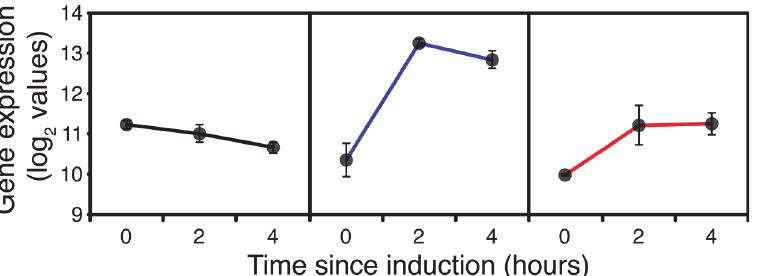
Fig 5. Expression of HAC1 during fed-batch culture, 0 (before), 2 and 4 hours after the start of methanol addition to wild-type GS115 (black), TRY1-1 (blue) and TRY1-3 (red), strains containing 1 and 3 gene copies of the human typsinogen gene, respectively, under the control of the AOX1 promoter. Error bars show